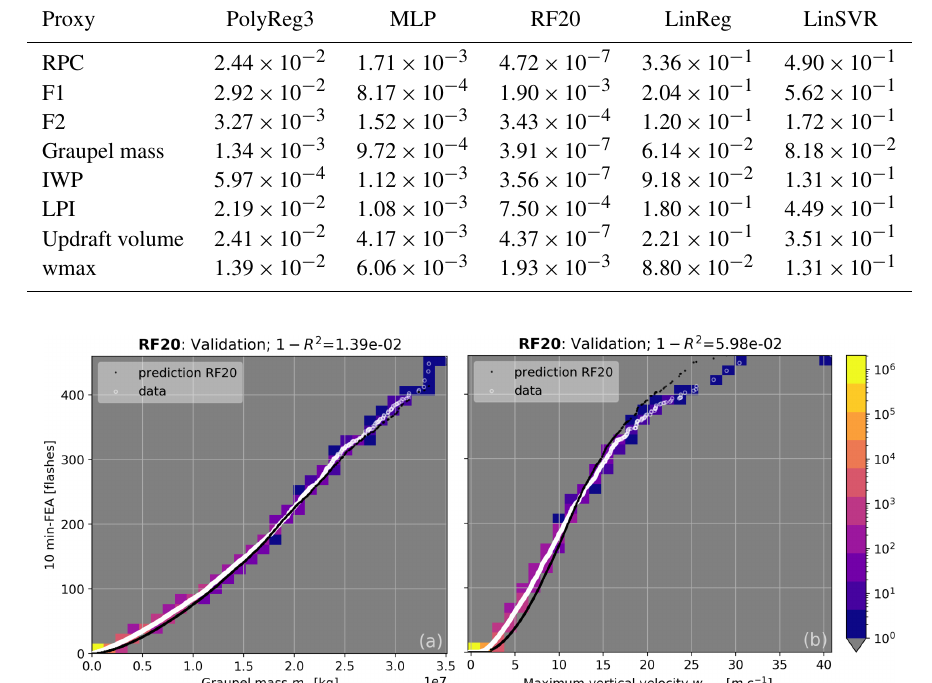
Table 2. The 1 − R 2 score for each regression model and each proxy at the training.